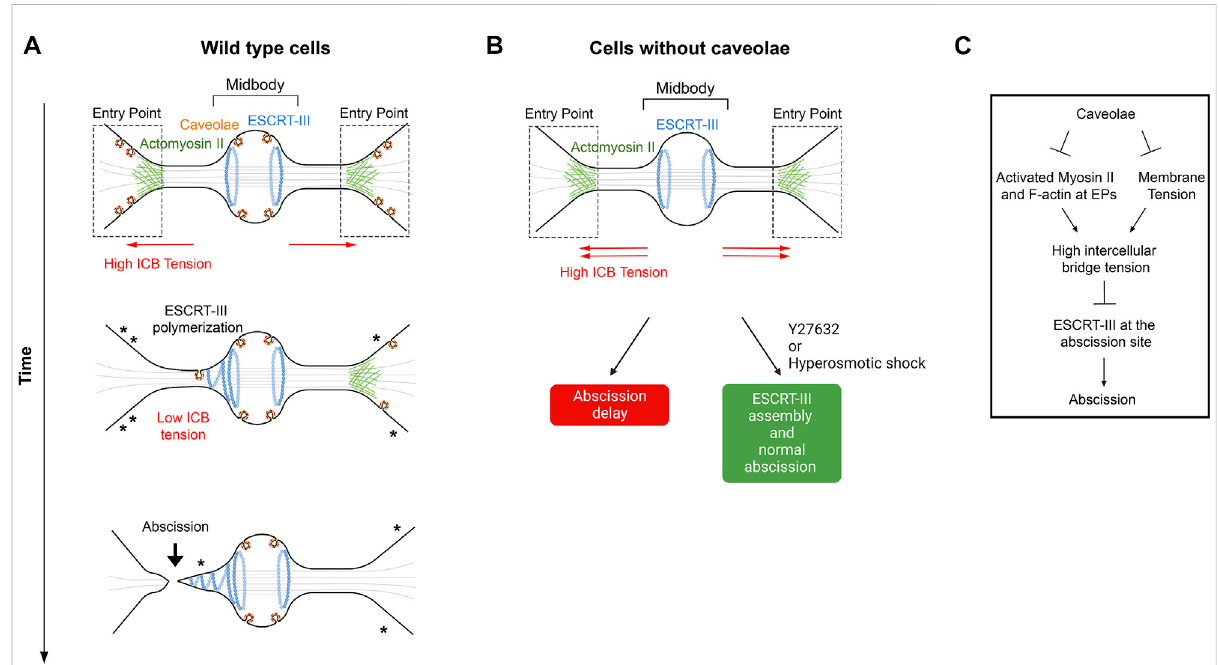
FIGURE 4 – CaveolaeregulateICBtensionandESCRT-IIIpolymerizationattheabscissionsite. A -Workingmodelforcaveolae-mediatedregulationofthe ICB tension. Note the progressive disappearance of caveolae (where asterisks are represented), possibly by fl attening, at the Entry points while cells progress toward abscission. This membrane fl attening is proposed to contribute to a decrease of the ICB tension, which promotes ESCRT-III polymerizationandabscission. B- Depletionofcaveolaeleadstoabscissiondelay,whichcanbecorrectedbyeitherY27632 (ROCKinhibitor) or hyperosmotic shock treatments. C- Schematic summary of events regulated by caveolae at the ICB. Adapted from (Andrade et al., 2022). EPs: Entry